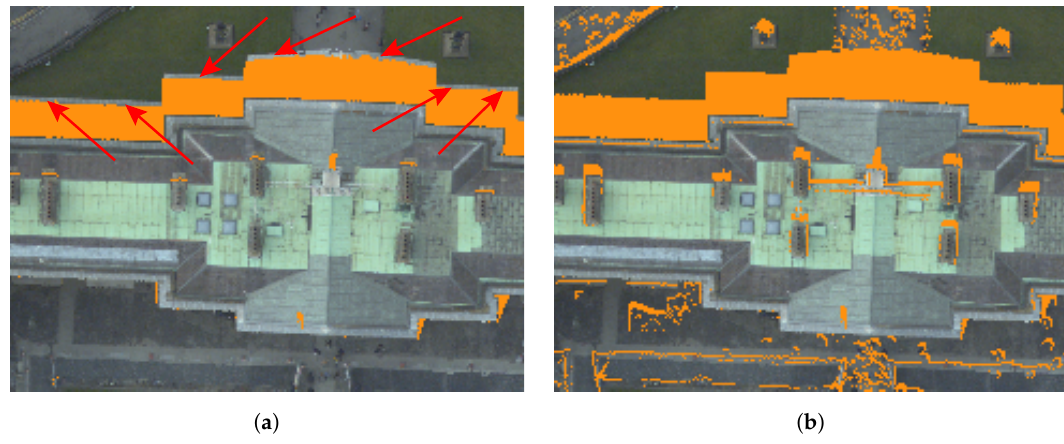
Figure 15. The impact of occlusion extension on the angle-based occlusion detection results: ( a ) sample results before occlusion extension, and ( b ) after applying an occlusion extension equal to 0.1 ◦